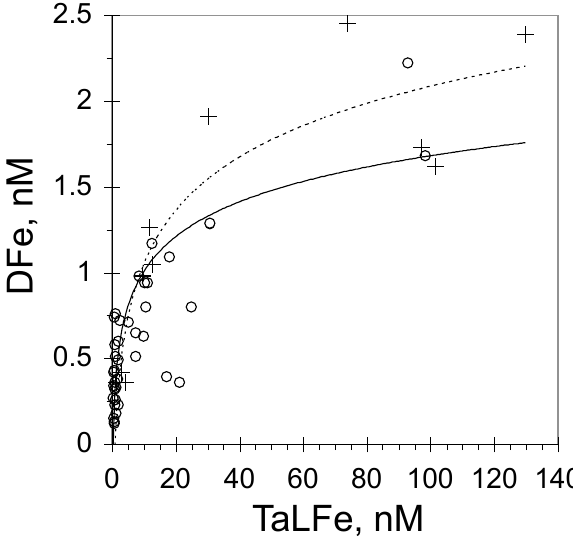
Fig. 6. Evidence of benthic input of Fe into coastal wasters. Up- per water column characteristics at the three outer coastal survey stations (light lines, station #8 and 9, and one station in between) and at the three stations closest to shore (dark lines, station #15 and 16 and one station to the east of station #16). (a) profiles of in situ chl- a fluorescence; (b) profiles of beam attenuation at 660nm. f